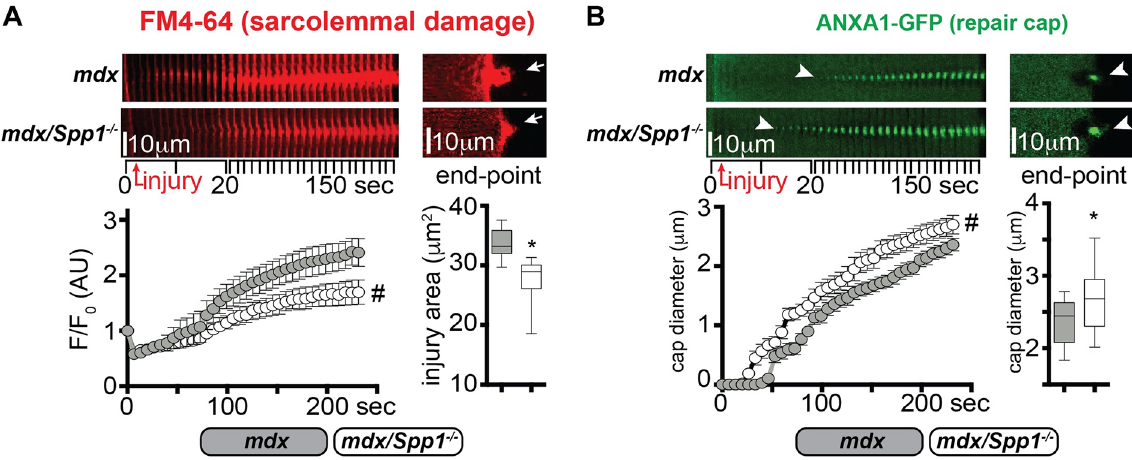
Fig 2. mdx mice lacking osteopontin (mdx/ Spp1 -/- ) recoverfrom sarcolemmal injury more efficiently. A) The sarcolemmal woundingassay was performed on flexor digitorumbrevis myofibers from mdx or mdx/Spp1 -/- animals, after electroporation with the ANXA1-GFP-encoding plasmid. The extent of sarcolemmal damage, monitored through accumulation of FM4-64 dye after laser injury, was significantly reducedin mdx / Spp1 -/- myofibers comparedto control dystrophicmyofibers. This was quantifiedover time as dye accumulationat site of injury (left) and area of injury at end-point(right; arrows). The time series (left images)represent stacked consecutive images of the injuredsite at 10˚ orientationto reveal the extent of dye accumulation. B) Repair cap onset, monitored by GFP-tagged ANXA1, was significantly faster in mdx/Spp1 -/- myofibers (arrowheads), resultingin a larger cap diameter at end-point (arrowheads). Time series of stacked consecutiveimages of the injured site at 10˚ orientationrevealedthe extent of dye accumulation or repair cap formation. FM4-64 and ANXA1-GFP pictures were acquiredsimultaneously. Marked line plots, avg ± sem; box plots, Tukey distribution; n = 40 myofibers (4 mice)/group; #, P < 0.05vs mdx control, 2way ANOVA + Bonferroni; * , P < 0.05 vs mdx control, unpairedt-test with Welch’s